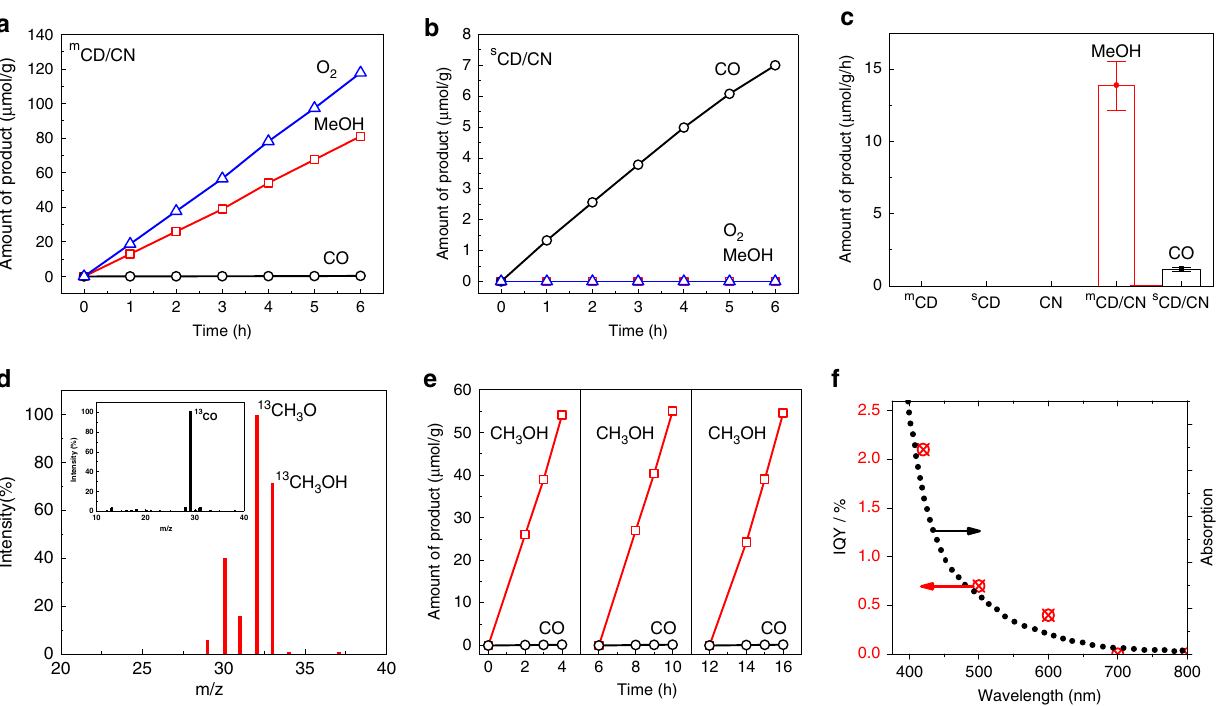
Fig. 3 Photocatalytic CO 2 conversion to methanol. The photocatalytic activity of a m CD/CN and b s CD/CN measured under visible light ( λ > 420 nm). c Control experiments on m CD, s CD, CN, m CD/CN and s CD/CN. Error bar: m CD/CN 13.9 ± 1.7 µ mol/g/h, s CD/CN 1.2 ± 0.2 µ mol/g/h. d Mass spectra of the product 13 CH 3 OH from 13 CO 2 photoconversion by the m CD/CN photocatalyst. Inset: the mass spectra of the 13 CO from 13 CO 2 photoconversion over the m CD/CN photocatalyst. e Consecutive three runs of CO 2 photoconversion to methanol on m CD/CN under visible light. f IQY of m CD/CN measured at atmospheric pressure under nearly one sun irradiation condition. Source data are provided as a Source Data fi